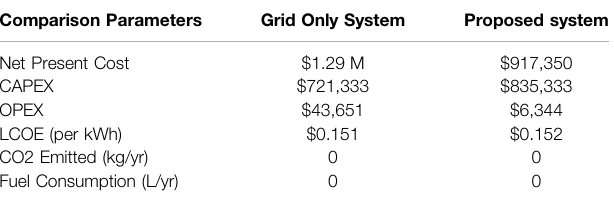
TABLE 6 | Economical Comparison between grid only system and proposed system.